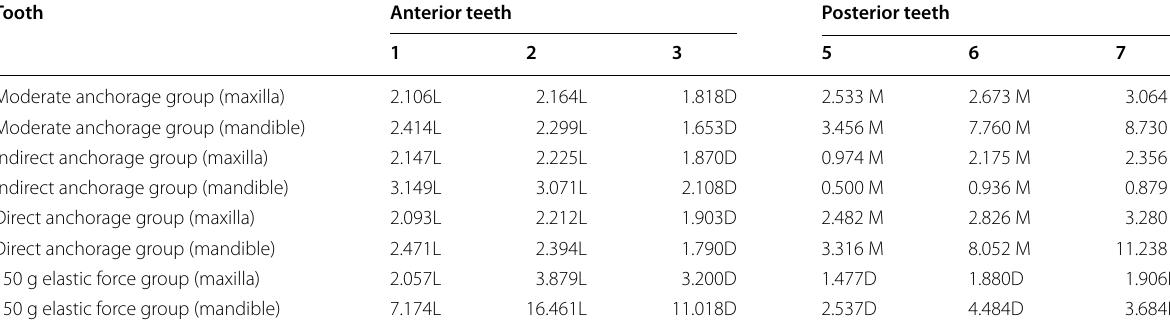
The root control effect is reflected by the crown-root movement ratio; the calculation is described in the Methodology section. The value with the same direction can be directly compared; the larger the value, the greater the root control ability of the corresponding direction. L, lingual root control ability; M, mesial root control ability; D, distal root control ability. 1, central incisor; 2, lateral incisor; 3, canine; 5, second premolar; 6, first molar; 7, second